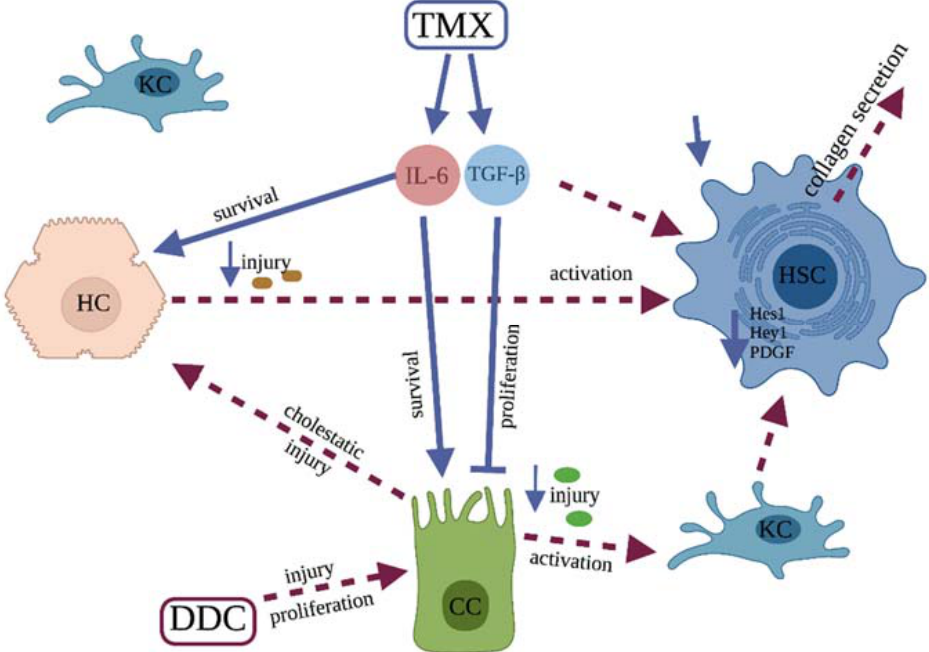
Figure 5. Proposed mechanism of the protective effect of tamoxifen. Tamoxifen treatment leads to Increased expression of TGF- β which is one of the activation signals for hepatic stellate cells, but this action is overridden through inhibitory effect on cholangiocyte proliferation. Furthermore, increased expression of IL-6 promotes survival of both hepatocytes and cholangiocytes thereby decreasing the profibrotic activation of Kupffer and hepatic stellate cells. Tgf β —transforming growth factor β